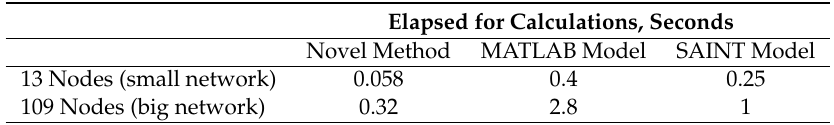
Table 6. Elapsed for calculations in seconds for each